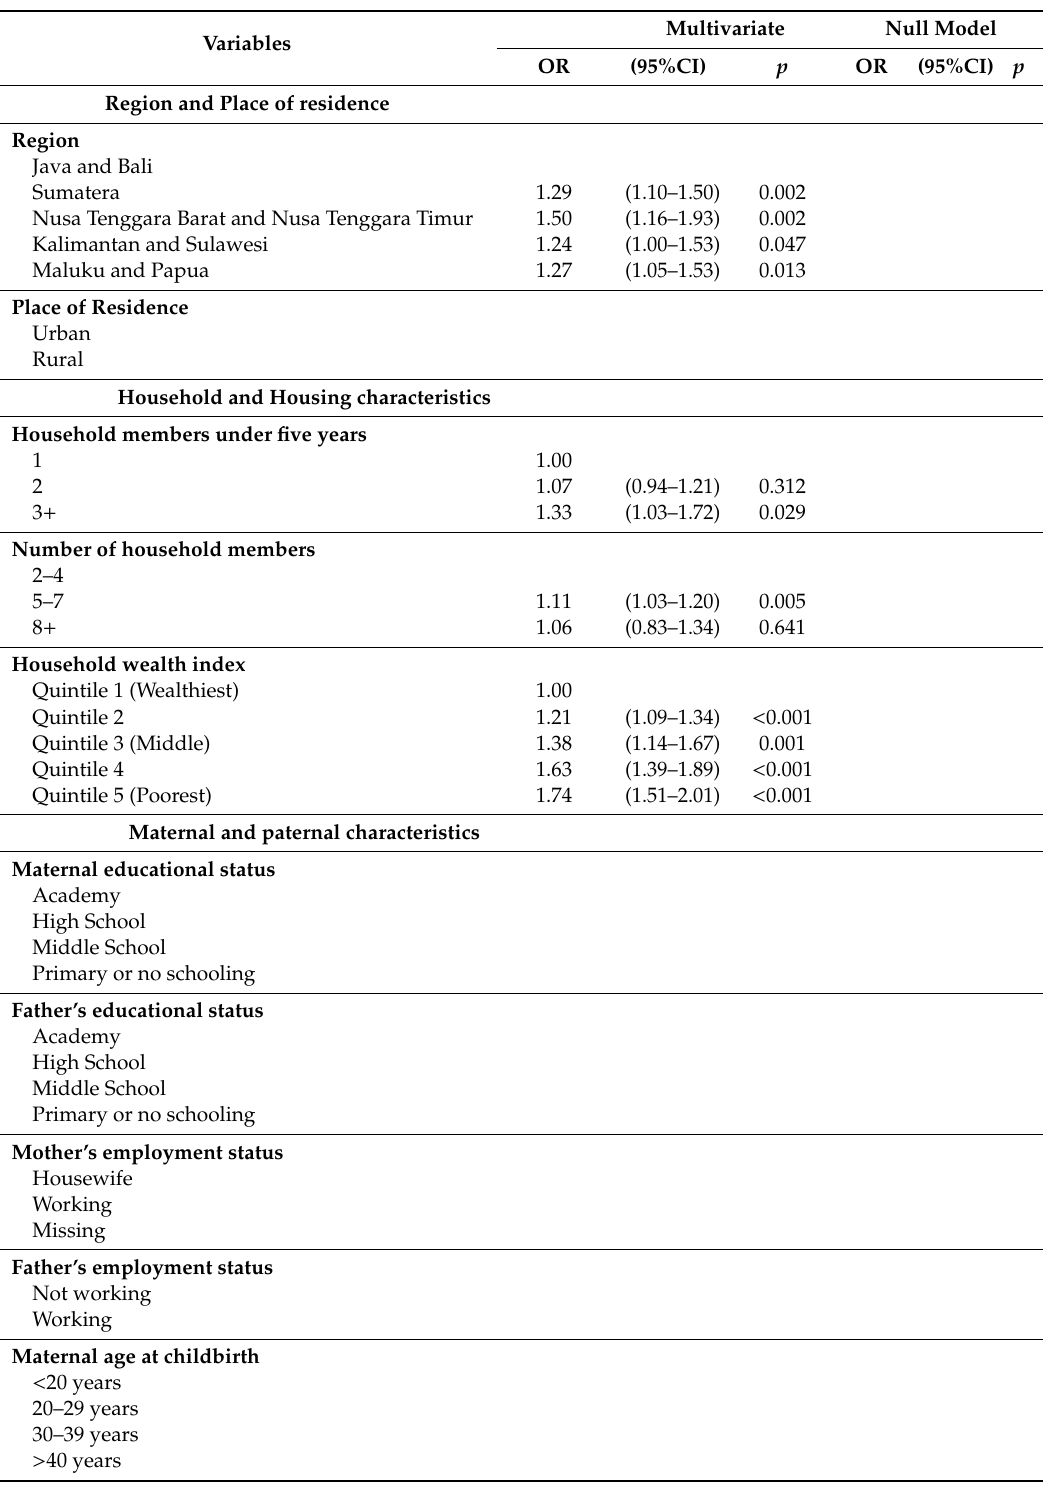
Table 2. Factors associated with stunting among children under two-years-old, The 2013 Indonesia Basic Health